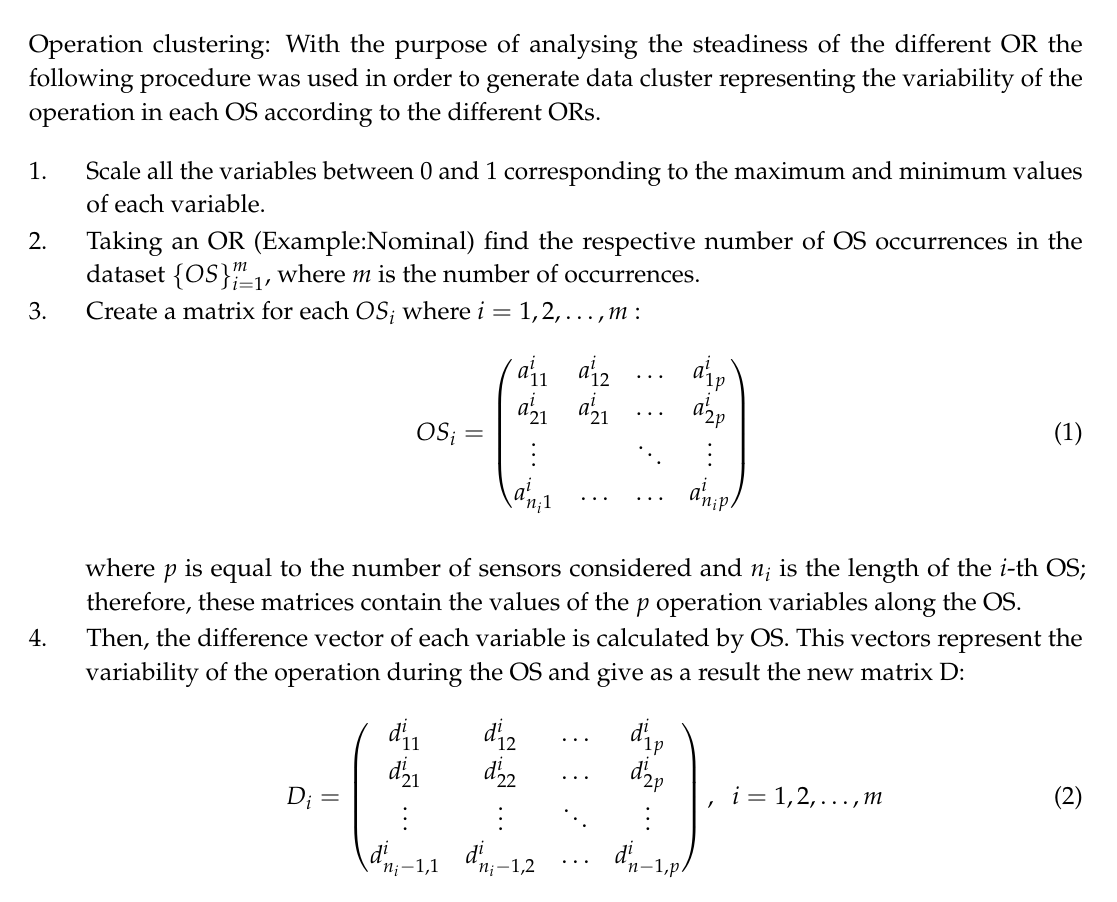
Figure 1. Operation regions over active power against wind speed